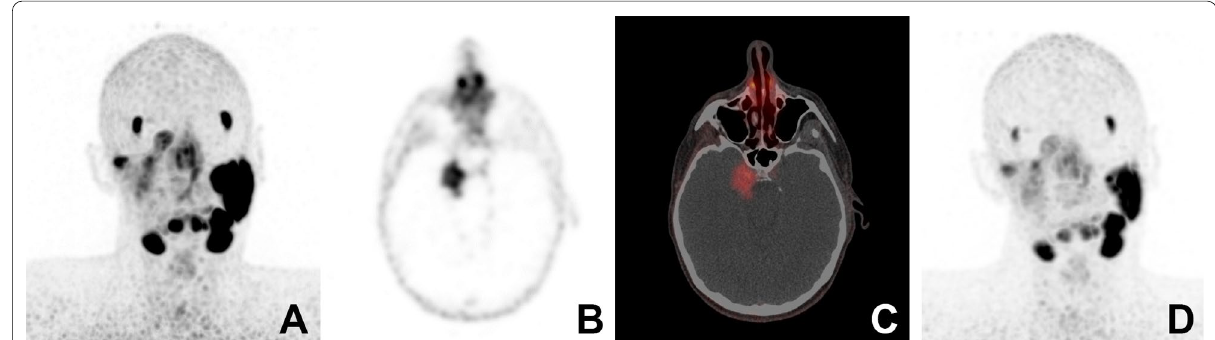
Fig. 1 Patient no. 2 suffering from recurrent and metastatic AdCC of the right parotid gland. Imaging depicts moderate PSMA-ligand uptake in the recurrent parapharyngeal and intracranial tumour localizations: before ( A , B and C ) and after ( D ) therapy. A Coronal maximum intensity projection (before therapy SUVmax 6.5); B axial PET; C axial PET/CT reconstruction; D coronal maximum intensity projection (after therapy SUVmax